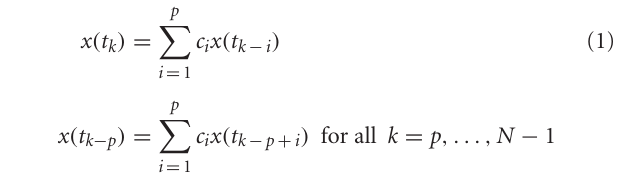
of a mechatronic hand orthosis (Tyromotion Amadeo HTS,